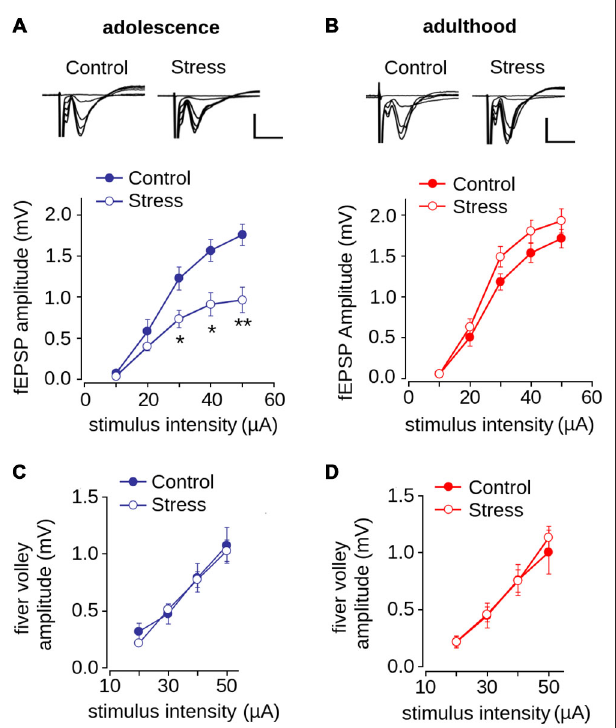
FIGURE 4 | Effect of repeated restraint stress during adolescence on synaptic transmission in layer 1 of mPFC is reversed in adulthood. (A,B) Input-output relationship of the average fEPSP amplitude as a function of stimulation intensity measured in adolescence (A) and adulthood (B) . Significant difference between control and stress groups ( ∗ p < 0.05; ∗∗ p < 0.01; Bonferroni post hoc test). Inset: representative superimposed traces of the fEPSP evoked at different stimulus intensities for control and stress groups. Scale bar: 1.0 mV; 5 ms. (C,D) Input-output relationship of the average fiber volley amplitude as a function of stimulation intensity measured during adolescence (C) and adulthood (D) . Data are expressed as mean ± SEM ( n = 4 animals, 17-23 slices).